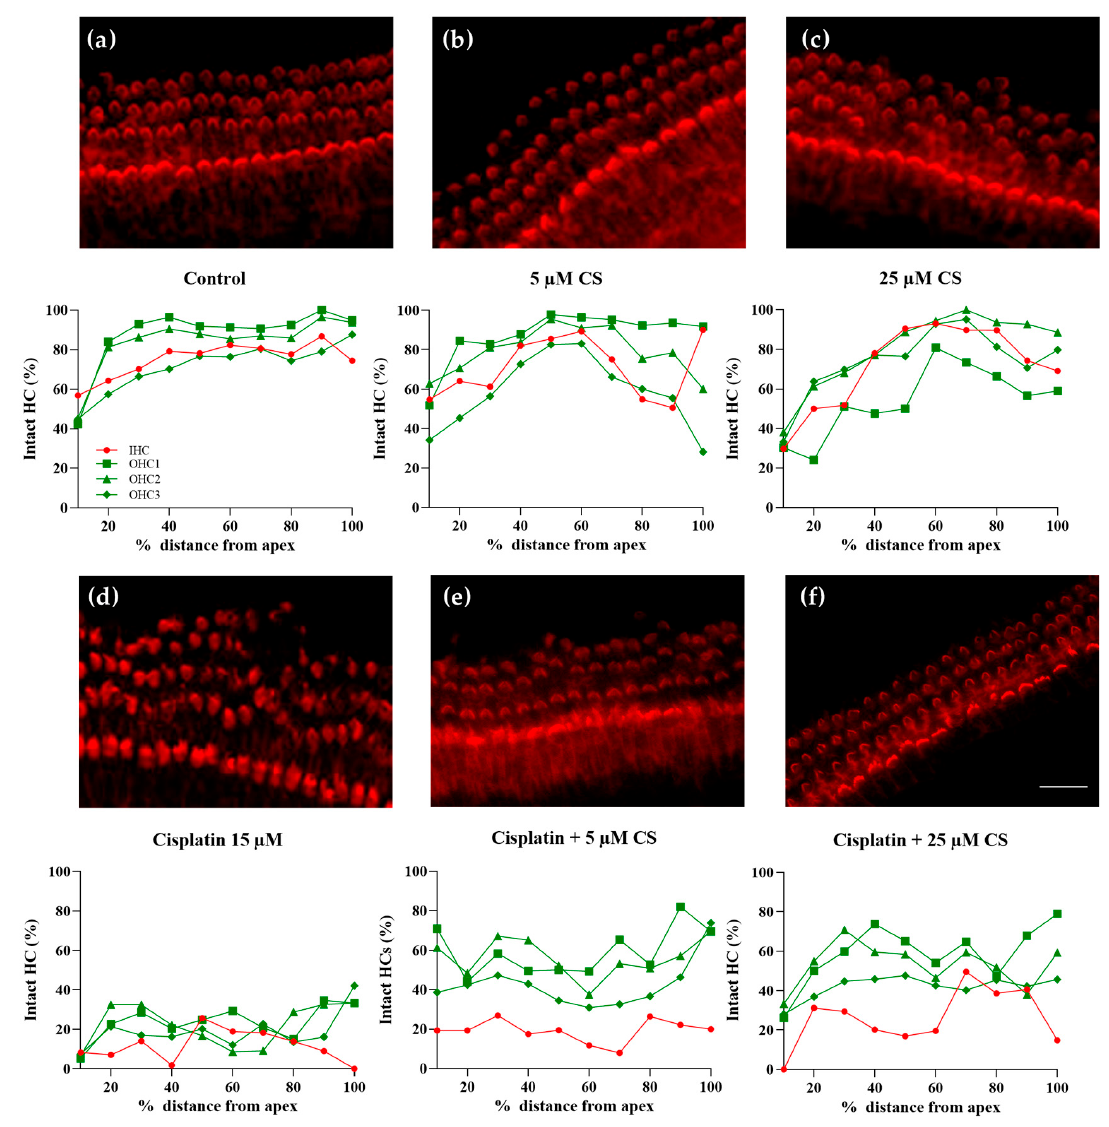
Figure 7. Cromolyn protects the cochlear tissues from cisplatin-induced hair cell damage and loss. The representative epifluorescence images of phalloidin-iFluor-594-stained cochlear explants and the representative cochleograms from each experimental condition are presented. In the cochleograms, the mean percentage per section of intact hair cells is plotted in relation to the distance from the base to the apex. The cochlea was divided into 10 sections for scoring, each representing 10% of the total OC length (0% = apex − 100% = base). ( a ) A typical hair cell array was observed in the control explants. ( b ) Cromolyn (CS) used at 5 µ M does not affect the HCs. ( c ) Cromolyn at 25 µ M does not affect the HCs. ( d ) Exposure to 15 µ M of cisplatin (Cis) reduces the percentage of intact HCs. ( e ) Cromolyn used at 5 µ M or ( f ) 25 µ M protects the HCs from the cisplatin-induced damage. The scale bar represents 10 µ m. For group statistics, see Figure